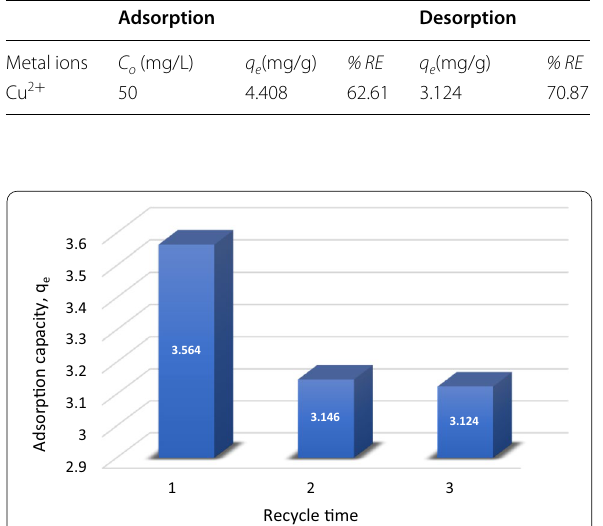
Fig. 16 Desorption of copper onto MNA-7 h in three